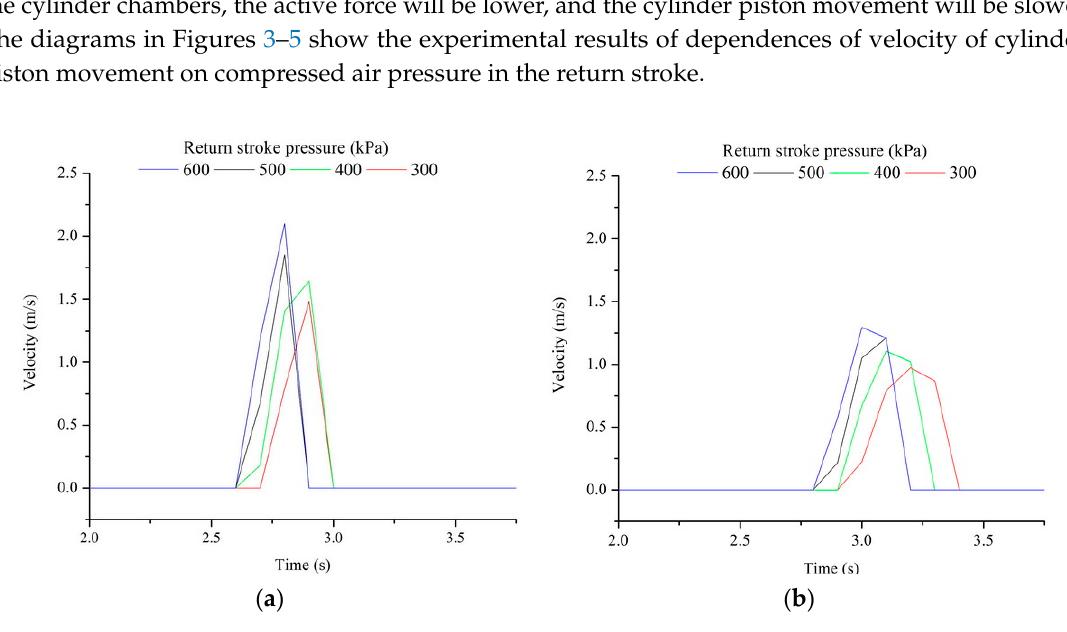
Figure 3. Velocity of cylinder piston movement. Diameter of cylinder: ( a ) 32 mm; ( b ) 40 mm.